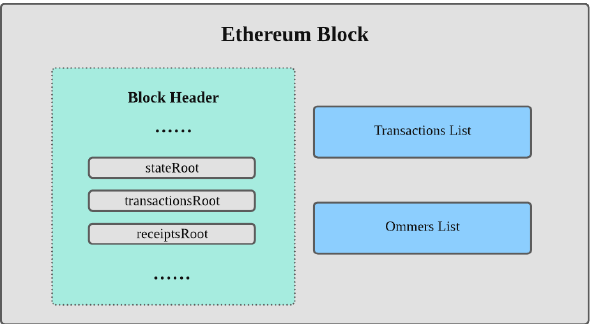
Figure 1. Ethereum block